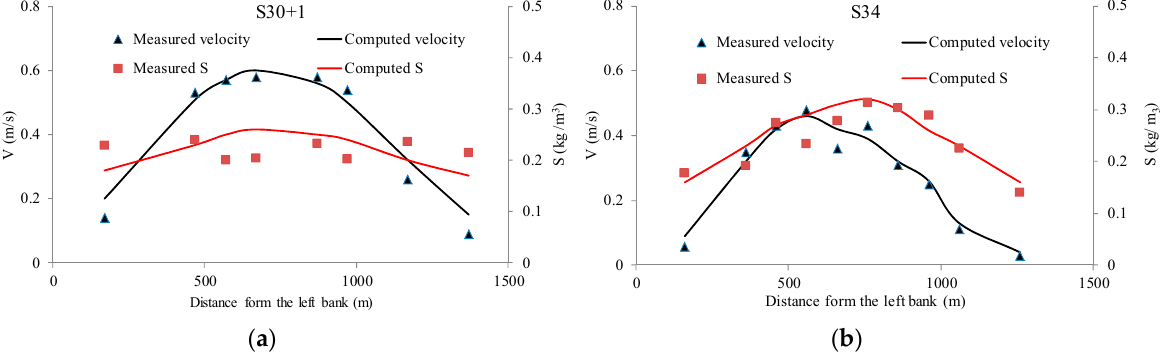
Figure 9. Verification of the velocity and sediment concentration distributions on typical cross ‐ sections. (a) on section S30+1; (b) on section S34.